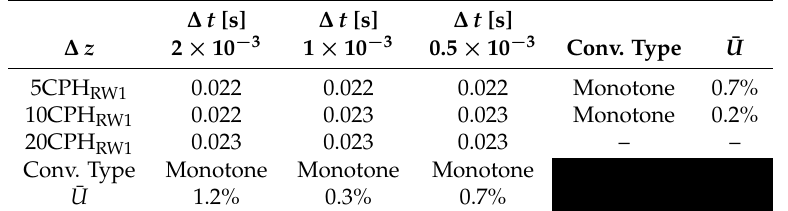
Table A2. Results of the spatial and temporal convergence study for RW1 ( T = 1 s, H = 0.02 m).